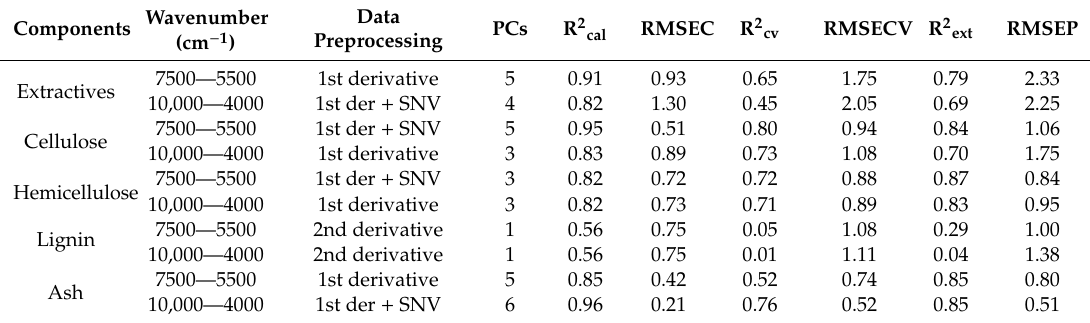
Table 2. Results of PLS1 calibration and prediction models developed for chemical composition of olive pruning biomass (% w /